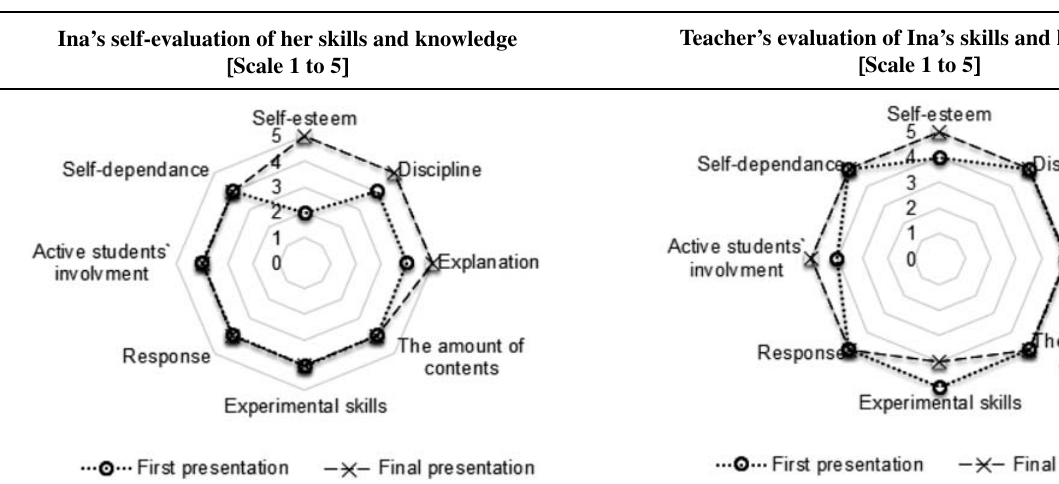
Table 3: Ina’s self-evaluation of her skills and knowledge in specific fields at her first and final presentation during their PPT in comparison with the evaluation of her school